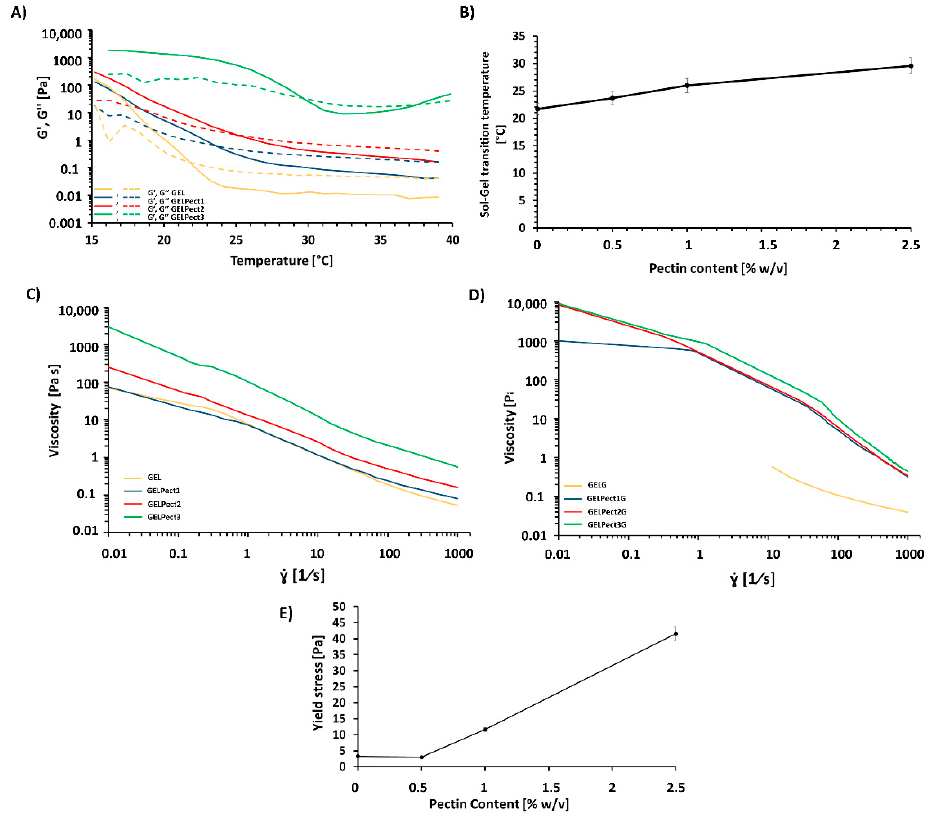
Figure 5. Temperature dependence of storage modulus (G’, continuous line) and loss modulus (G’’, dashed line) of GEL and GELPect slurries within the linear viscoelastic region (1 Hz, 0.1 Pa) ( A ); sol–gel transition temperature of GELPect slurries as a function of pectin concentration ( B ); experi- mental viscosity curves ( C , D ) at 25 °C of GEL and GELPect slurries ( C ), and of GELG and GELPectG biomaterial inks ( D ), and yield stress of GELPect slurries as a function of pectin content at 25 °C ( E ). Table 3. Yield stress values of GELPect slurries and GELPectG biomaterial inks. (The yield stress of GELG was not detectable). No GPTMS